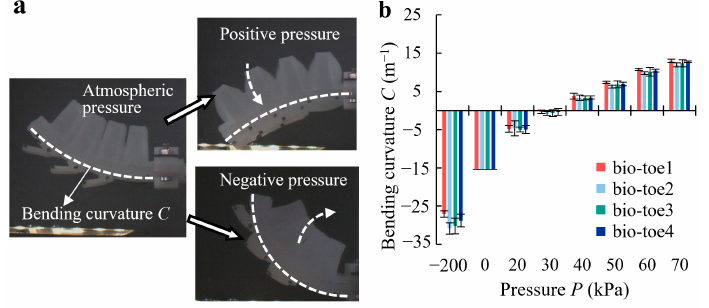
Figure 6. ( a ) State of the bio-toe under atmospheric, positive, and negative pressure. ( b ) Bending curvature of the four bio-toes versus pressure.